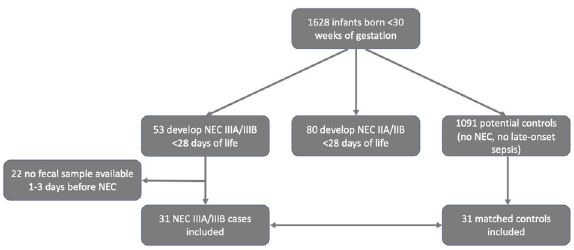
Figure 1. Flow chart of study subject enrollment. NEC necrotizing enterocolitis